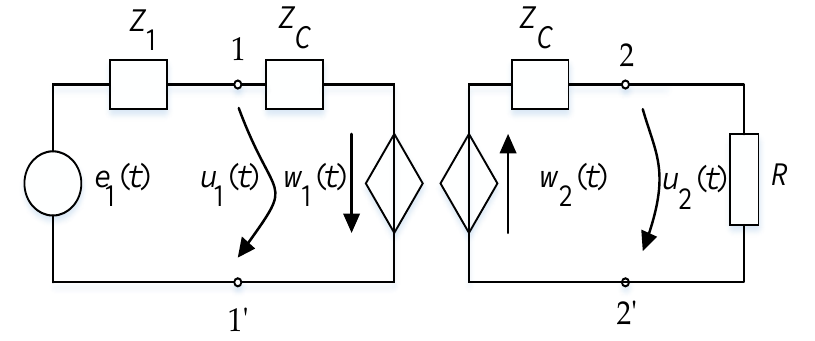
Figure 7. Equivalent circuit of bipolar transmission line.